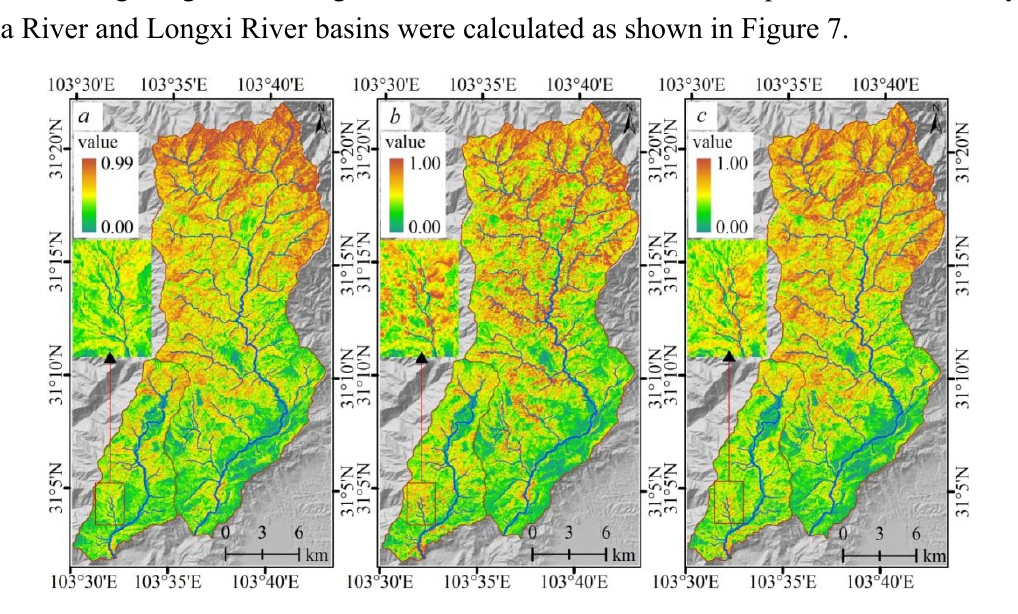
Figure 7. ( a ) Pre-earthquake; ( b ) 2008–2009; and ( c ) 2014 slope materials stability